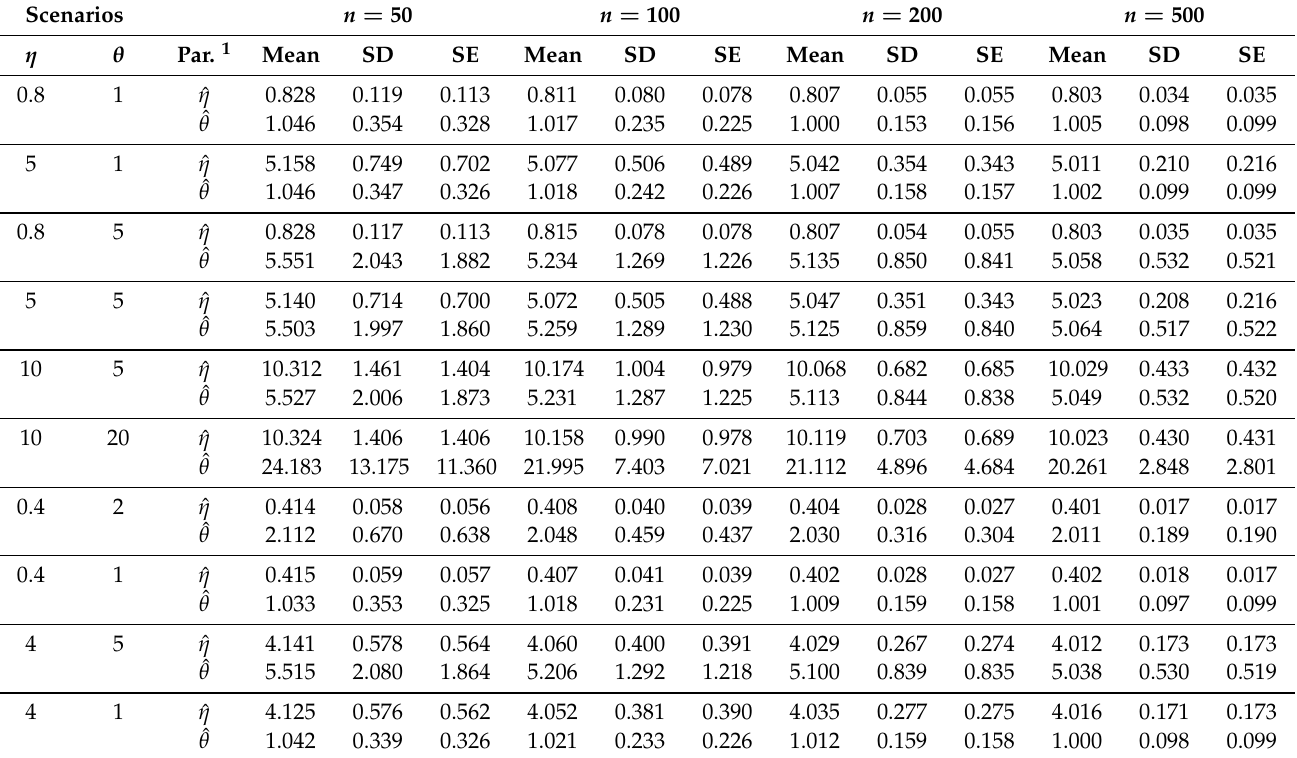
Table 1. Simulation results for the parameter estimation of the exponentiated exp-Pareto